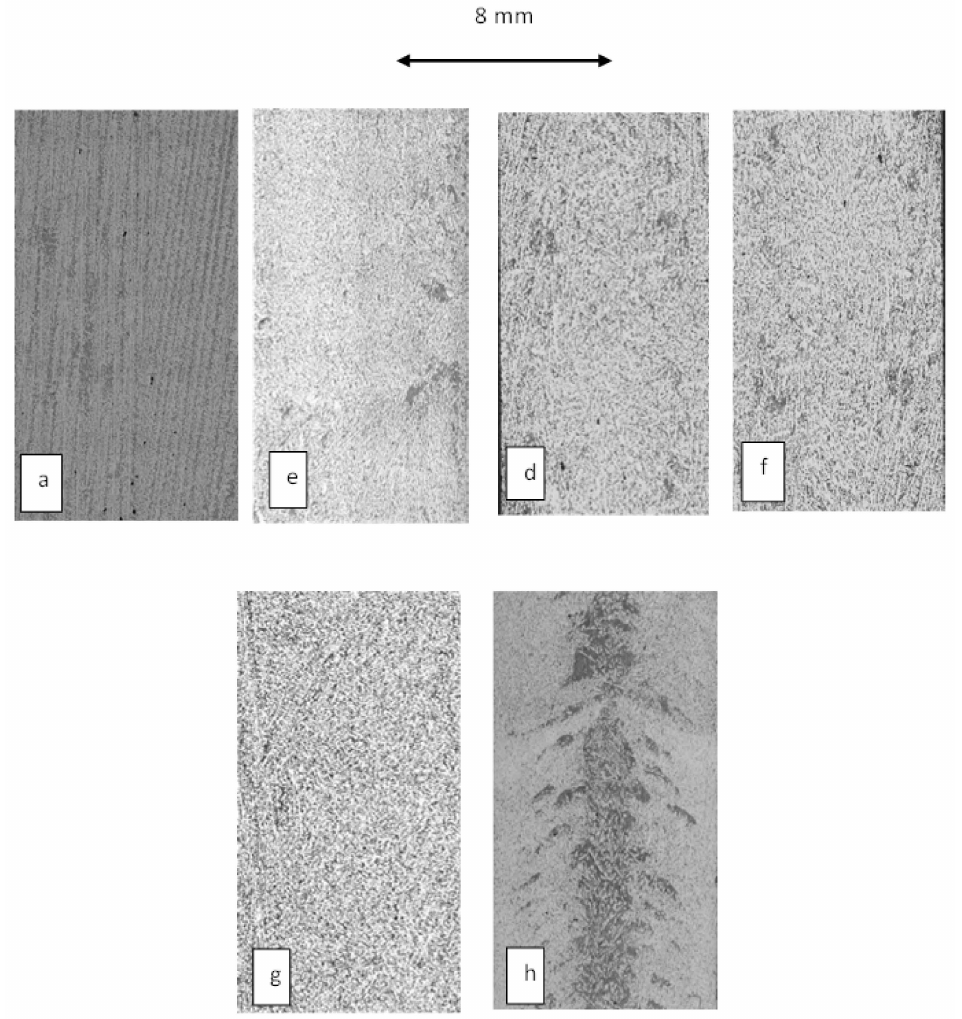
Figure 20. Macrosegregation in unidirectional solidification of the Al–7%Si–1%Fe alloy. Etching with 2 V% HF water solution. Temperature gradient (G): 5 K/mm, solid/liquid front velocity (v): 0.05 mm/s, “xy” type. ( a ) B = 0 mT, ( e ) B = 20 mT, ( d ) B= 40 mT, ( f ) B = 80 mT, temperature gradient (G): 5 K/mm, solid/liquid front velocity (v): 0.2 mm/s, ( g ) B = 80 mT, “xy” type, and ( h ) stirring by RMF (B = 80